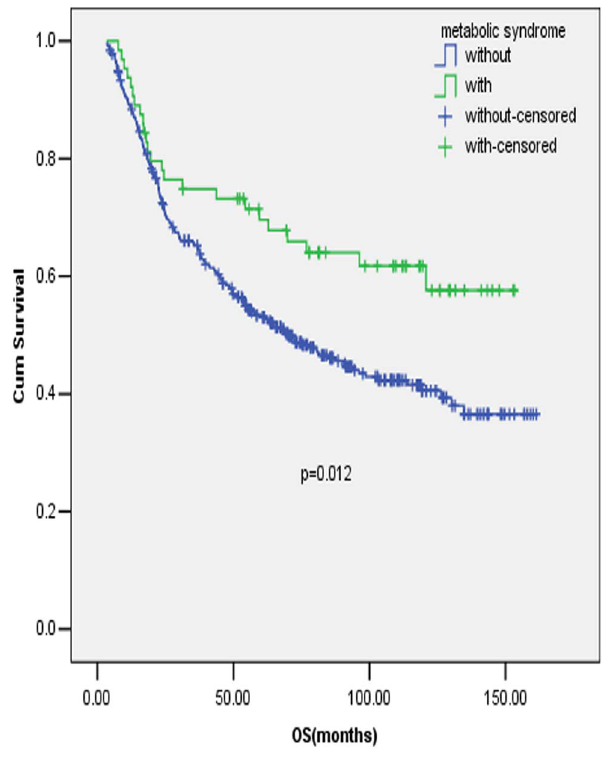
Figure 1. Prognostic value of MetS in early stage gastric cancer patients. Full legend: Patients with MetS had a trend of better survival compared with those without MetS in early stage gastric cancer (GC), but the difference was not statistically significant.